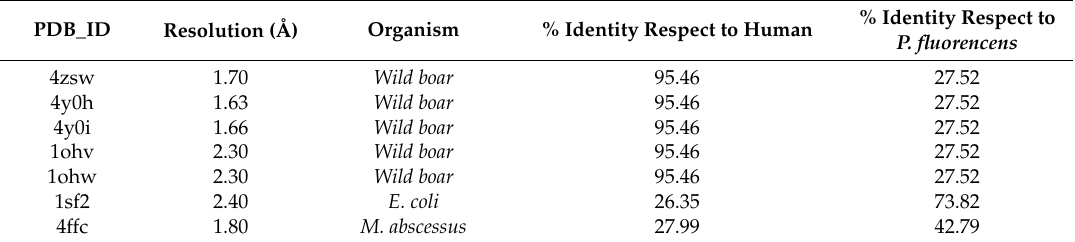
Table 9. GABA aminotransferase crystal structures available in PDB